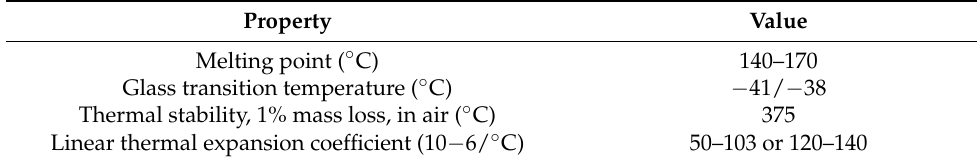
Table 2. PVDF thermal